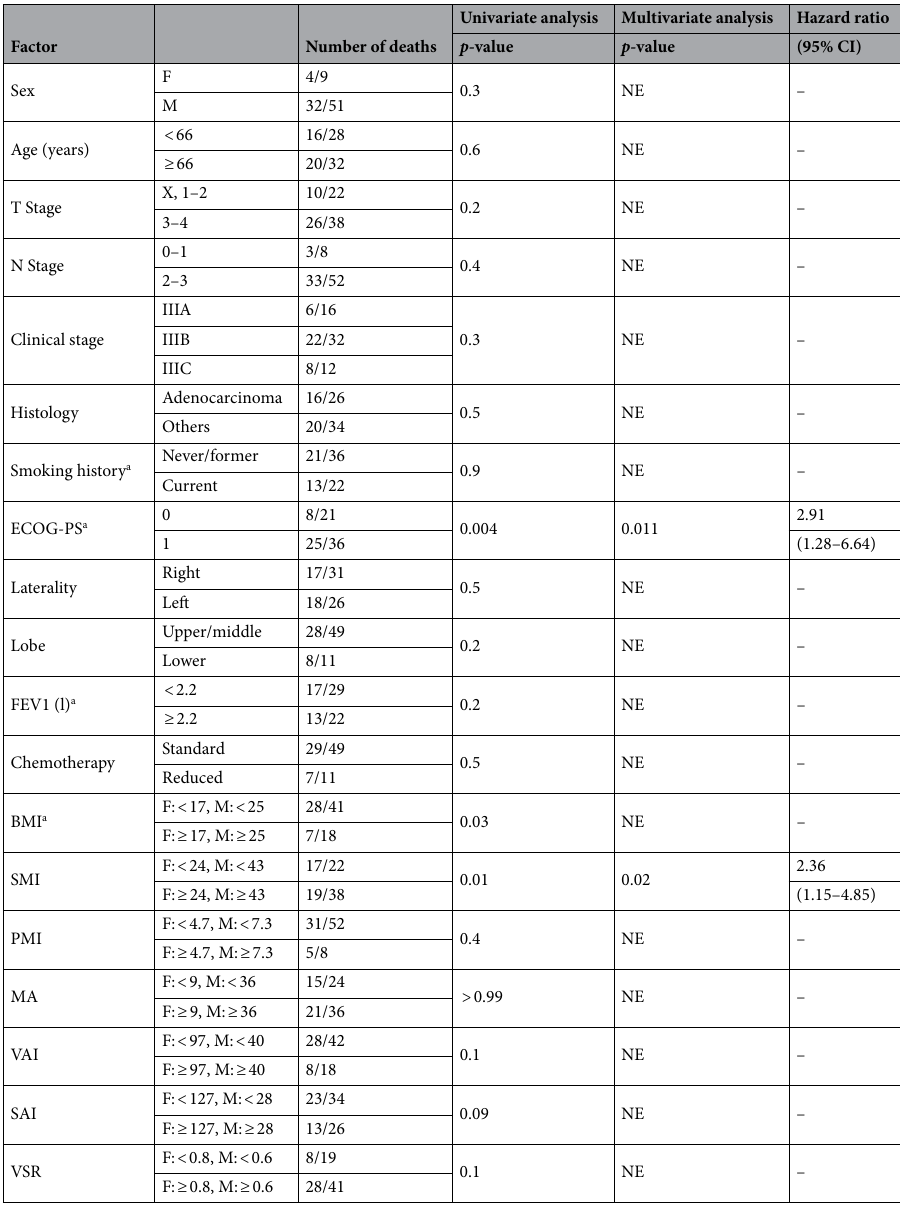
BMI body mass index, MA mean muscle attenuation, SMI skeletal mass muscle index, PMI psoas muscle index, VAI visceral adiposity index, SAI subcutaneous adiposity index, VSR visceral-to-subcutaneous fat ratio, CI confidence interval. a These variables have missing